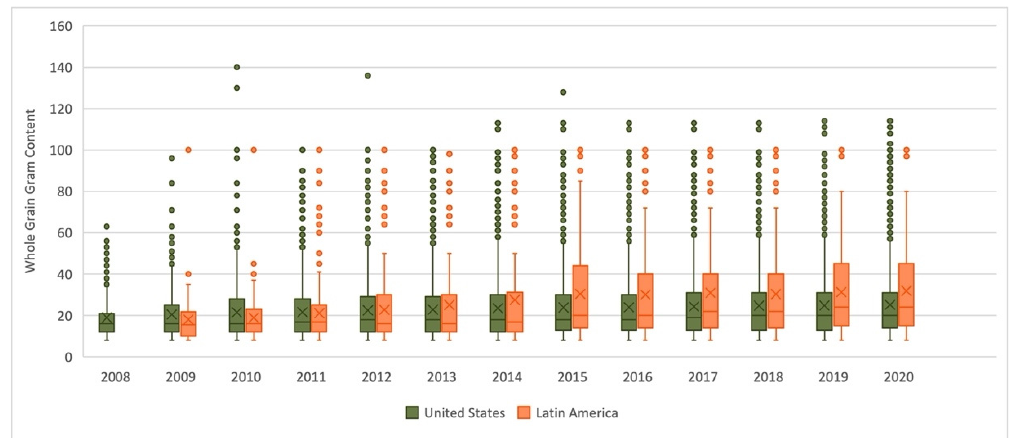
Figure 2. Whole-grain gram content of Whole Grain Stamped products.